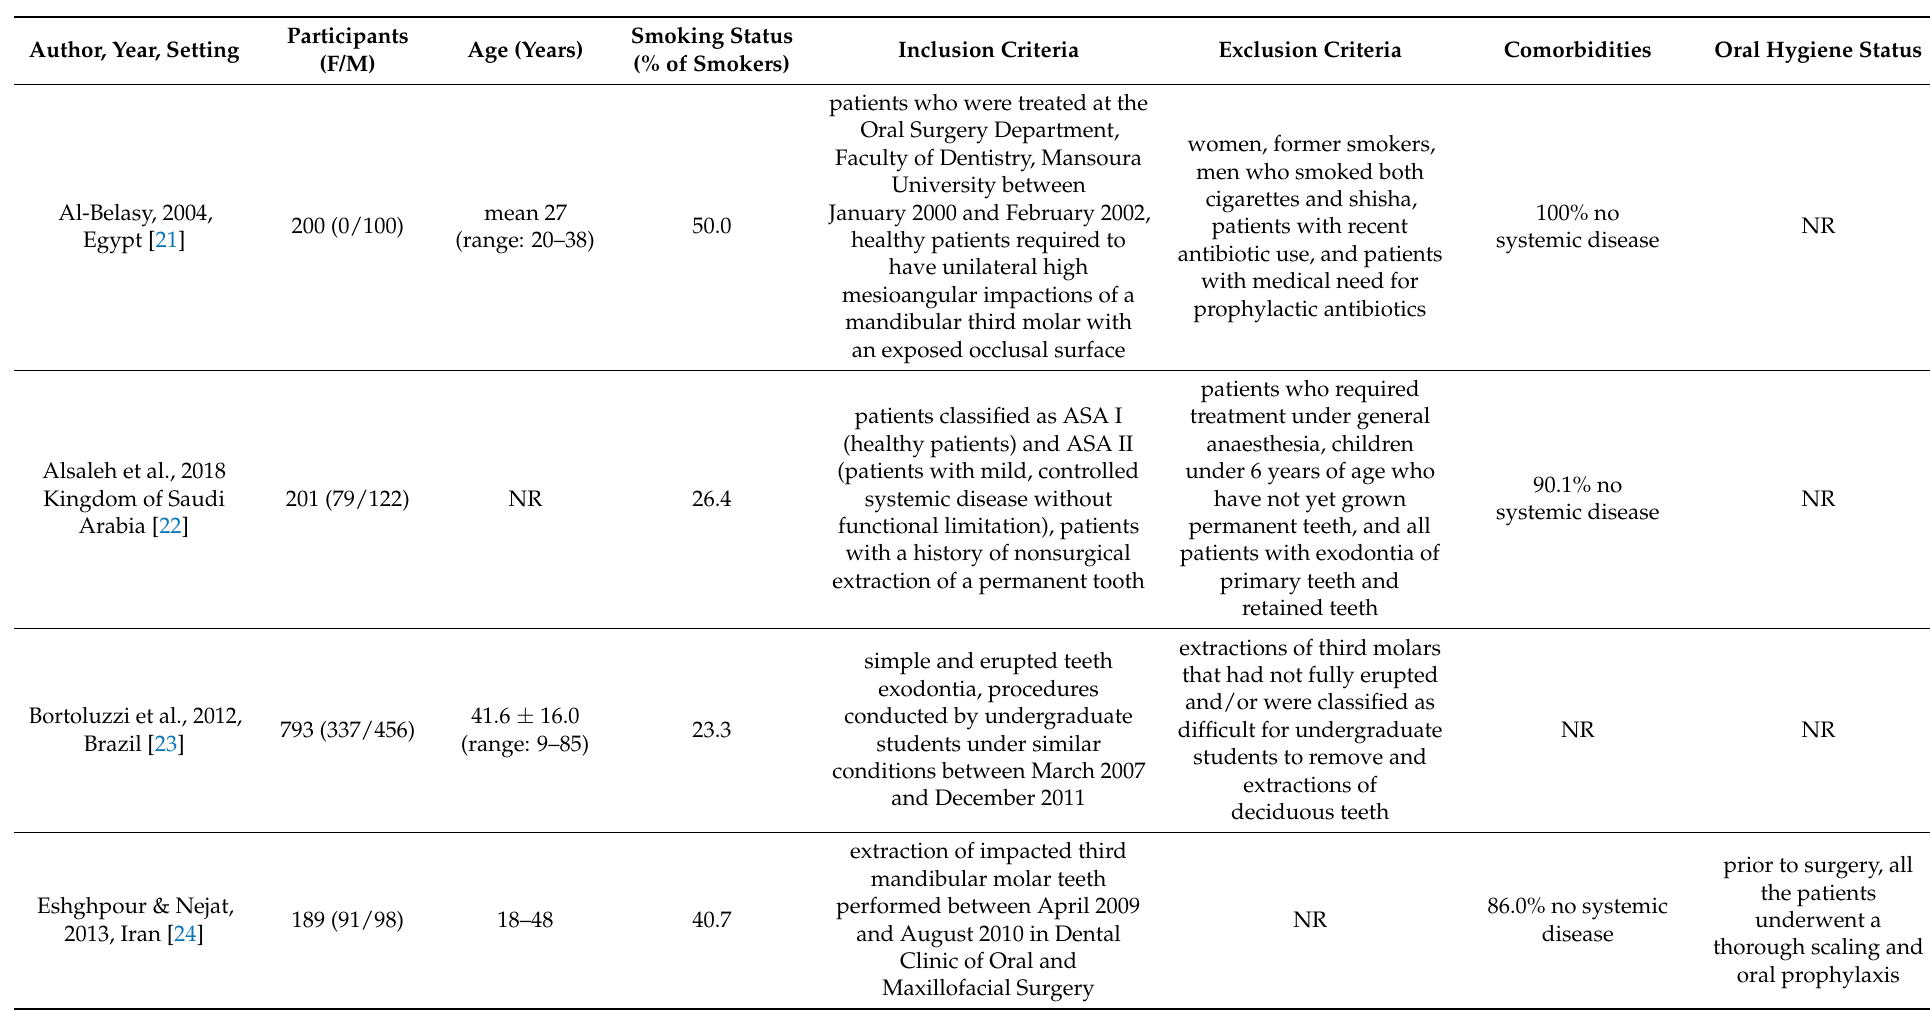
Table 2. General characteristics of included